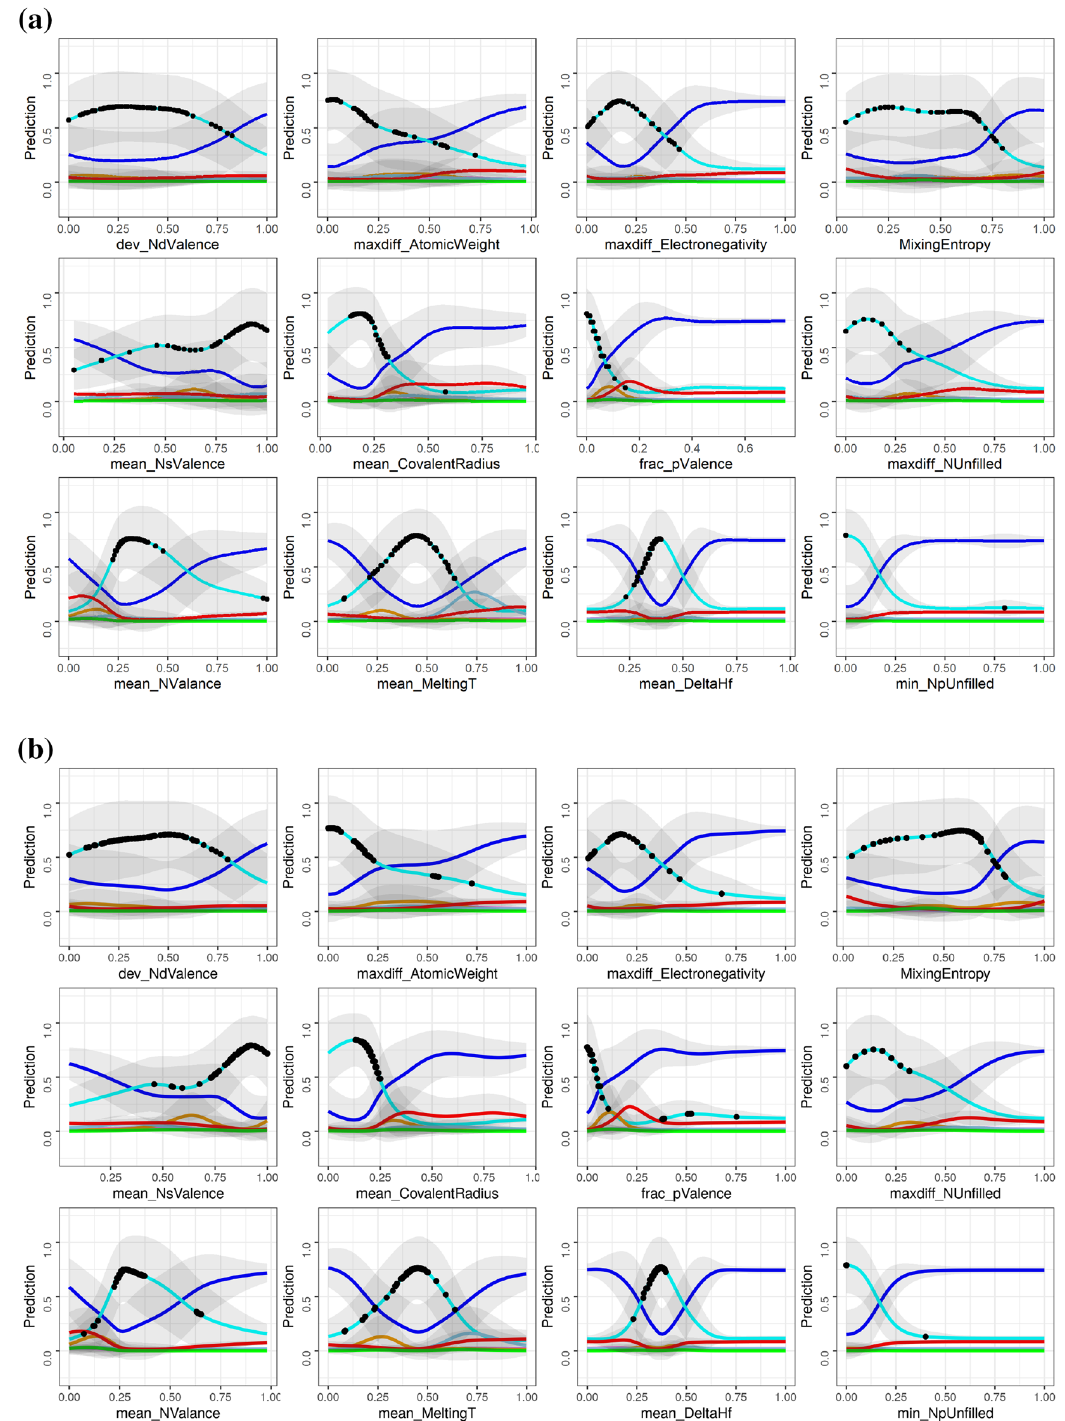
Figure 7. The averaged CP profiles with respect to the 12 input variables based on the ( a ) BD and ( b ) SHAP data of the representative clusters (clusters 3 and 10, respectively), which are predicted to form in the FCC phase by the eSVM model. The black dots indicate the true feature values for all the data points within a given cluster. Line colors denote phase information: blue, MP; violet, AM; cyan, FCC; orange, BCC+FCC; lightblue, HCP; red, BCC; green,